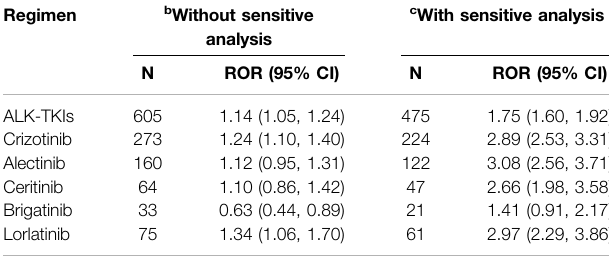
TABLE 2 | Signal detection of cardiac disorders a